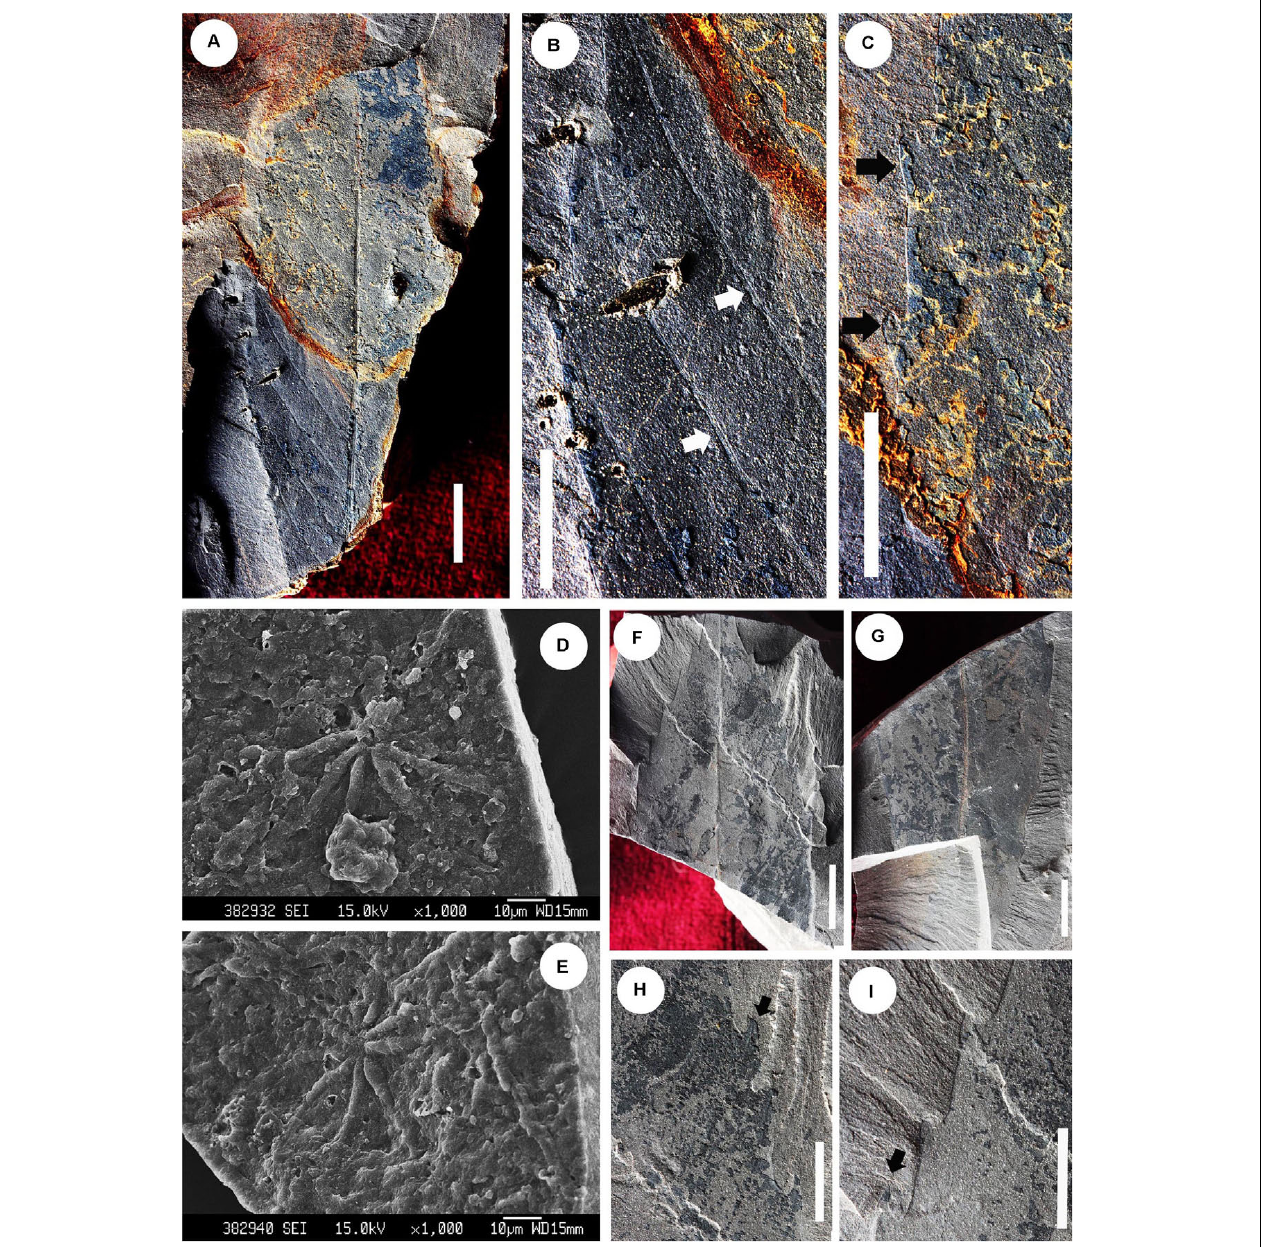
FIGURE 8 | Morphology of Castanopsis sp. (A) Specimen No. CC-1276, showing the leaf morphology; (B) enlargement of (A) , showing the secondary veins (white arrows) and tertiary veins; (C) enlargement of (A) , showing the teeth (black arrows); (D,E) SEM images showing the rugose outer surface and stellate trichomes. (F) Specimen No. CC-401, showing the leaf morphology; (G) specimen No. CC-343, showing the leaf morphology; (H,I) enlargement of (F) , showing the teeth (black arrows) and tertiary veins. Scale bars: 10 mm (A,F,G) ; 5 mm (B,C,H,I) .